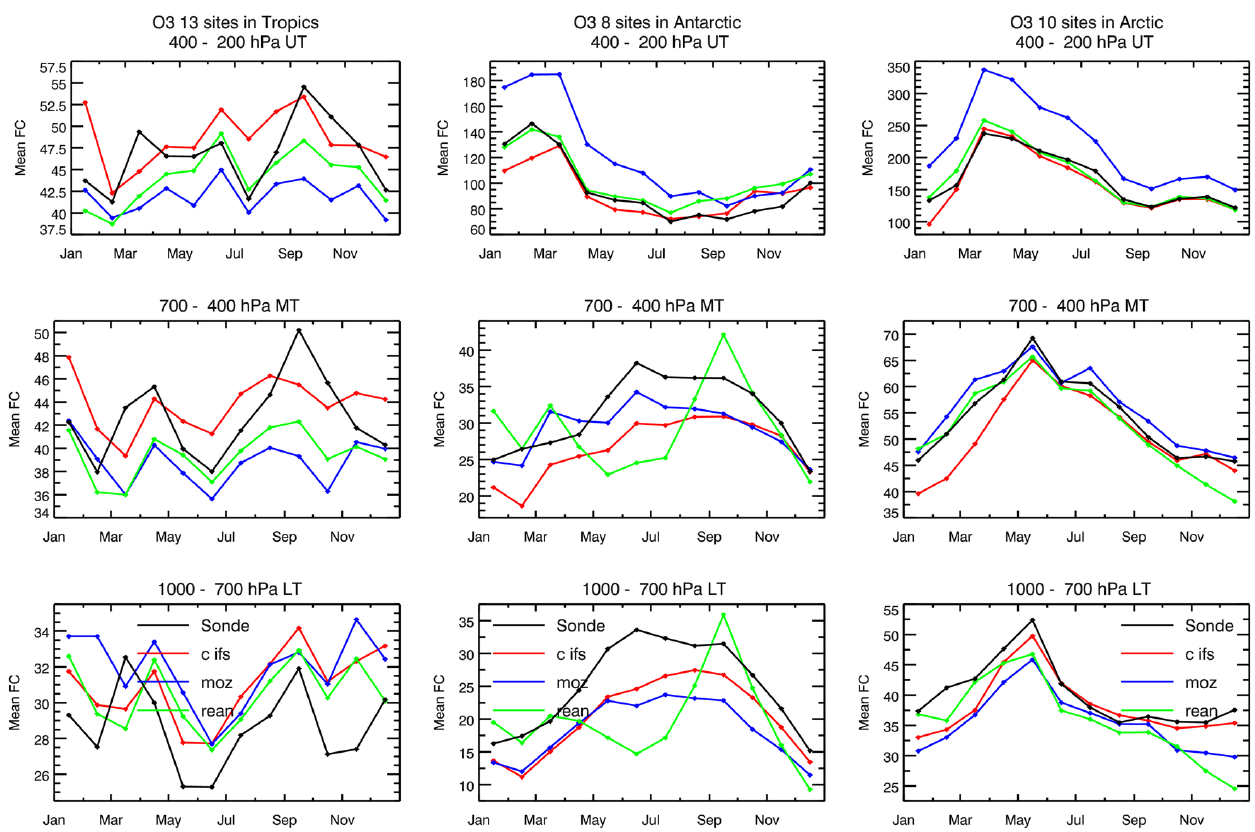
Figure 3. Tropospheric ozone volume mixing ratios (ppb) over the tropics (left), Antarctica (middle) and the Arctic (right) averaged in the pressure bands 1000–700hPa (bottom), 700–400hPa (middle) and 400–200hPa (top) observed by ozonesondes and simulated by C-IFS (red), MOZ (blue) and REAN (green) in 2008.